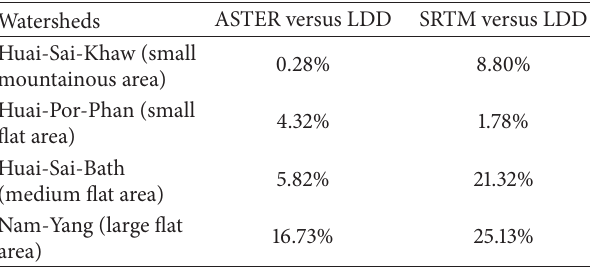
Table 11: Difference in stream lengths extracted from LDD DEM, ASTER DEM, and SRTM DEM.